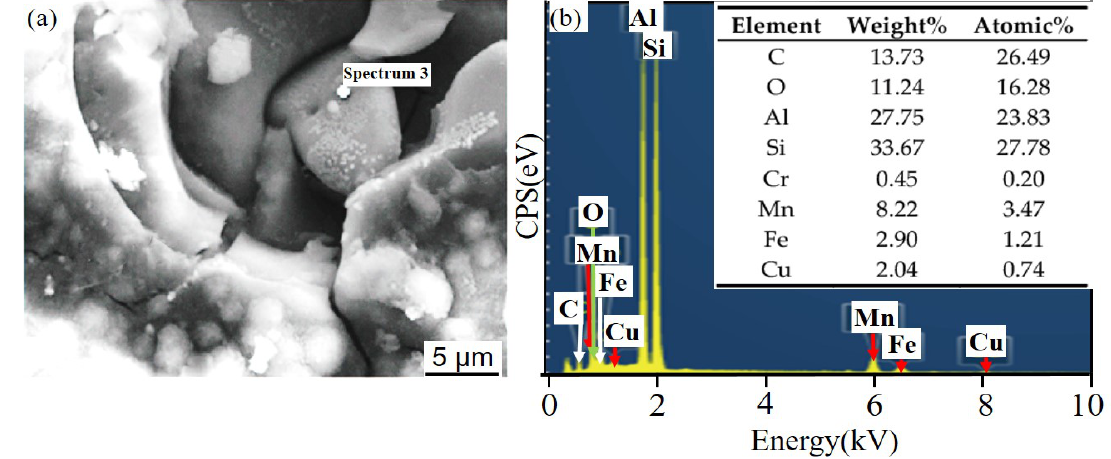
Figure 15. EDS of particles in the corrosion pit of SiC 3D /6061Al after SL for 21 days. ( a ) SEM image of particles in the corrosion pit; ( b ) EDS of particle.